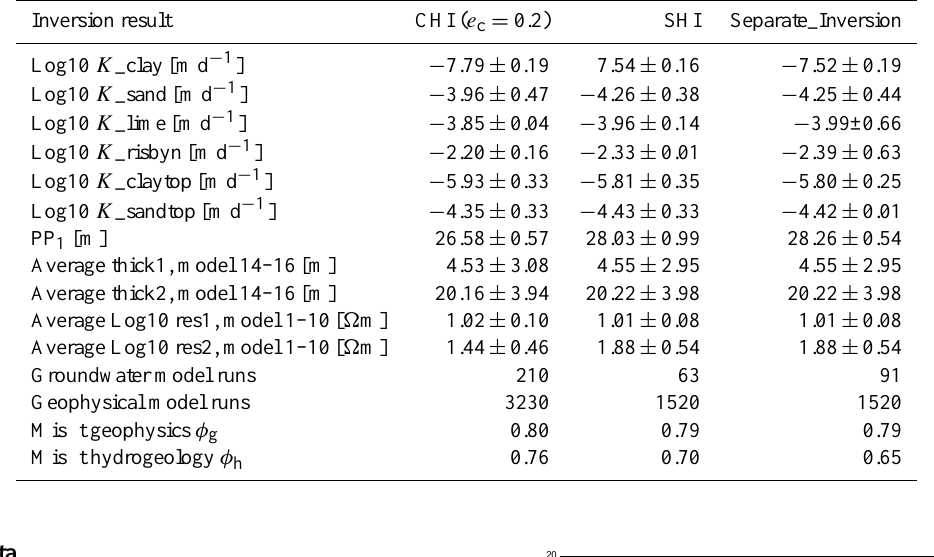
Table 3. Inversion results JHI and SHI for Risby landfill.